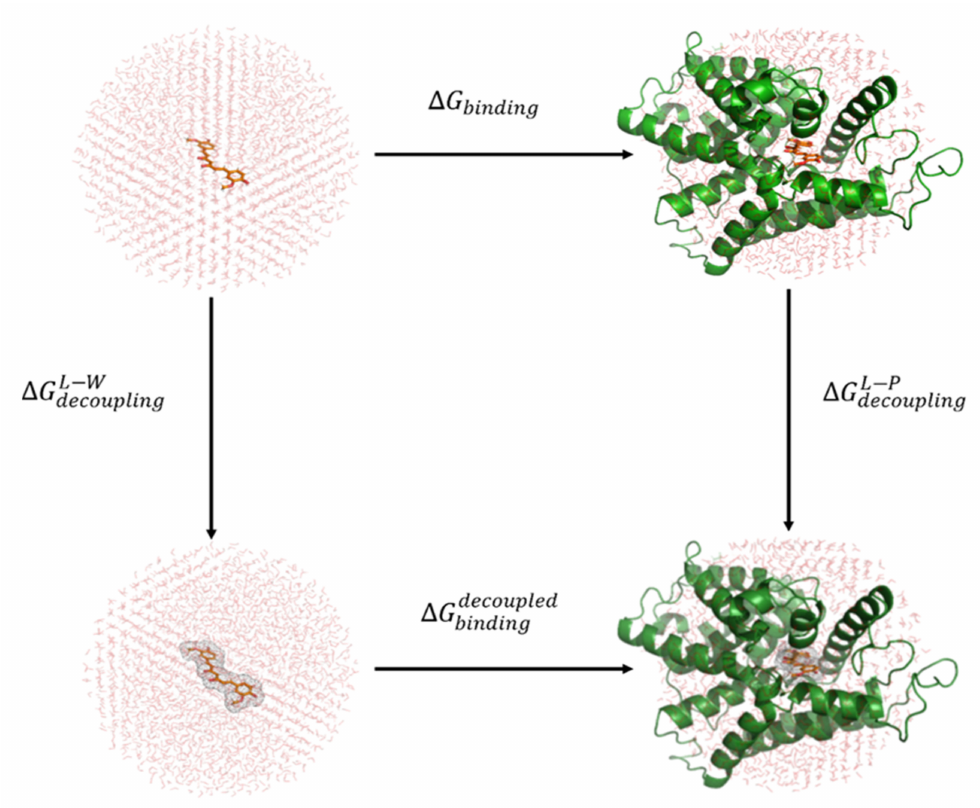
Figure 2. The thermodynamic cycle applied in the linear response approximation (LRA) method. Ligand L is shown in orange color, protein P is portrayed in green color, and red circle W symbolizes water molecules. Gray mesh surrounding the ligand L denotes decoupling–switching off the nonbonded (electrostatic and van der Waals)